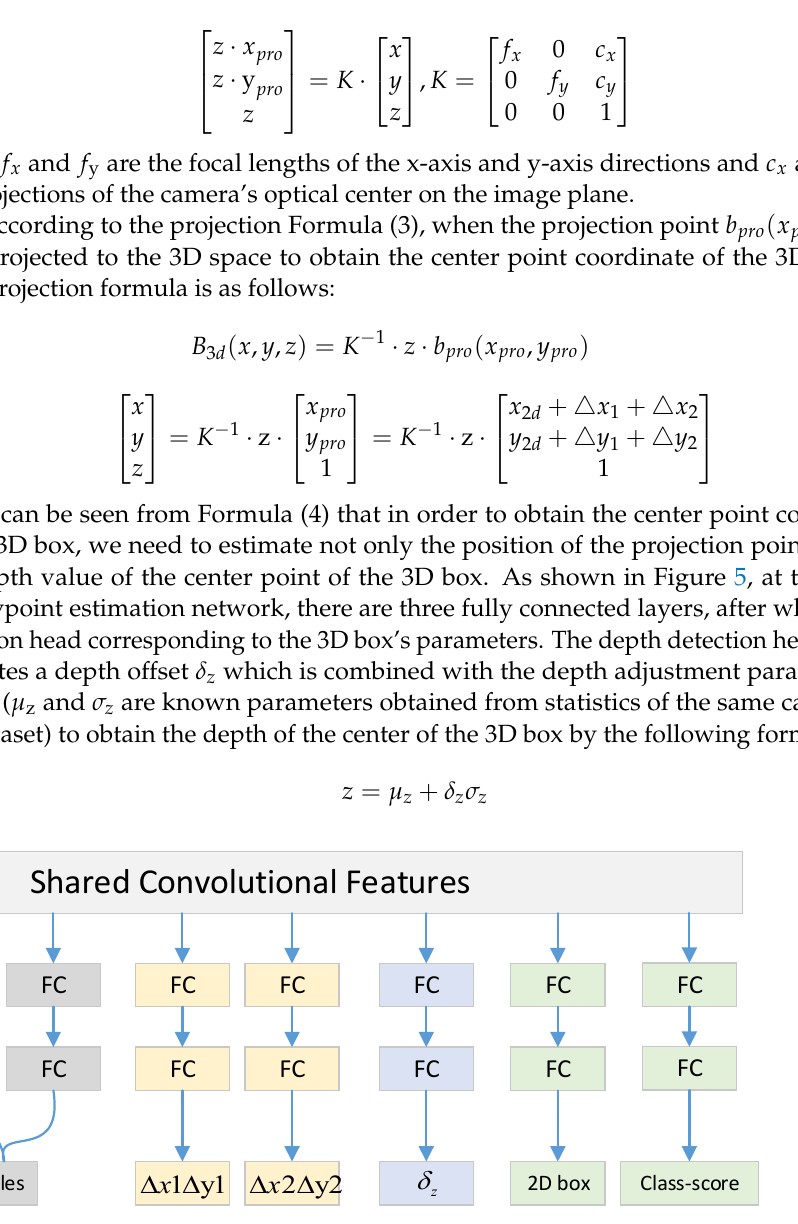
Figure 5. Detection head branches of the keypoint estimation network. After obtaining the depth value of the center point of the 3D box, the center point coordinates of the 3D box in the camera coordinate system can be obtained through the back-projection Formula